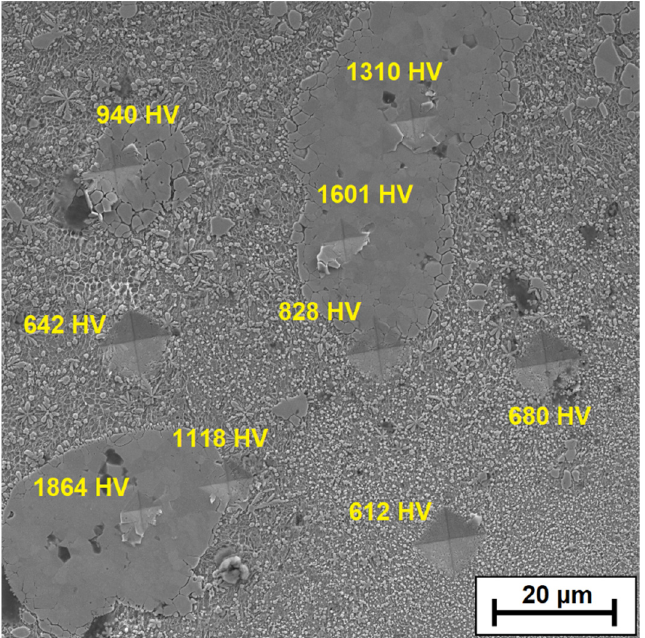
Figure 18. Examples of microhardness indentations for the reinforcing phase and the matrix—the middle part of remelted zone of Fe/ZrC coating produced using a laser beam power of 700 W .